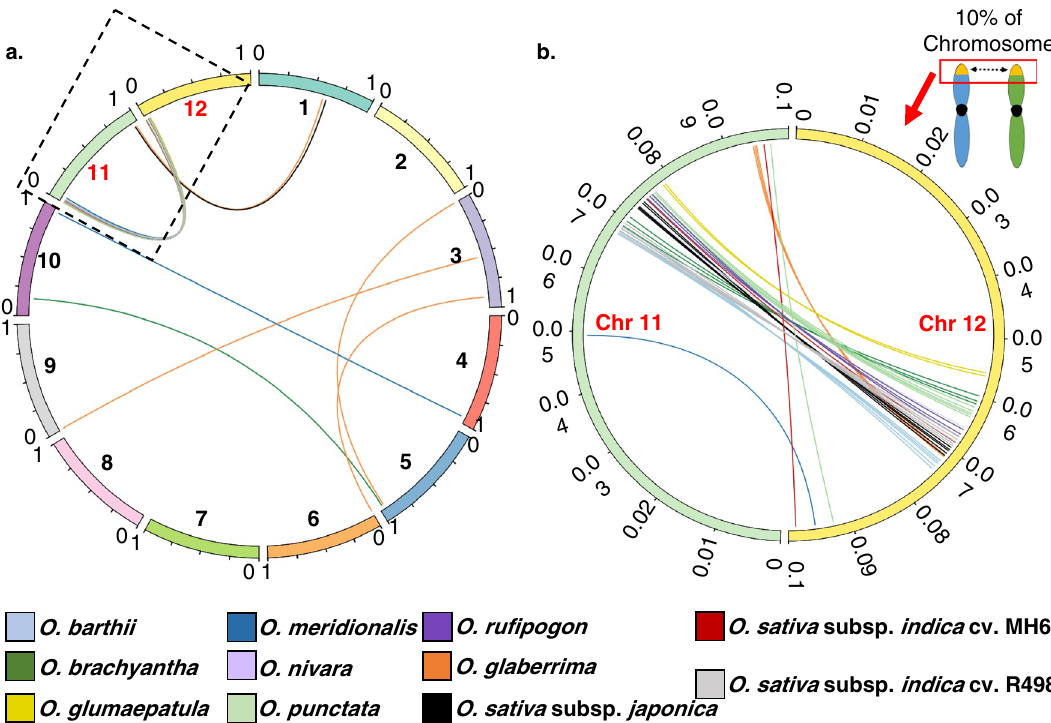
Figure 5. WRKY paralogs identified across the Oryza genomes. To compare chromosomes across different species, the chromosomes sizes were made to scale from 0 to 1. Paralogous relationships are represented by a line, indicating the position of a WRKY gene on each end. Each WRKY gene position is relative to its respective species on the 0 to 1 scale. ( a ) Syntenic relationship between 44 interchromosomal WRKY paralogs across all 12 chromosomes ( b ) Region enclosed in dashed box in A shows segmental duplication events at the distal 10% region of chromosomes 11 and 12 short arms have generated ~ 38% of total identified